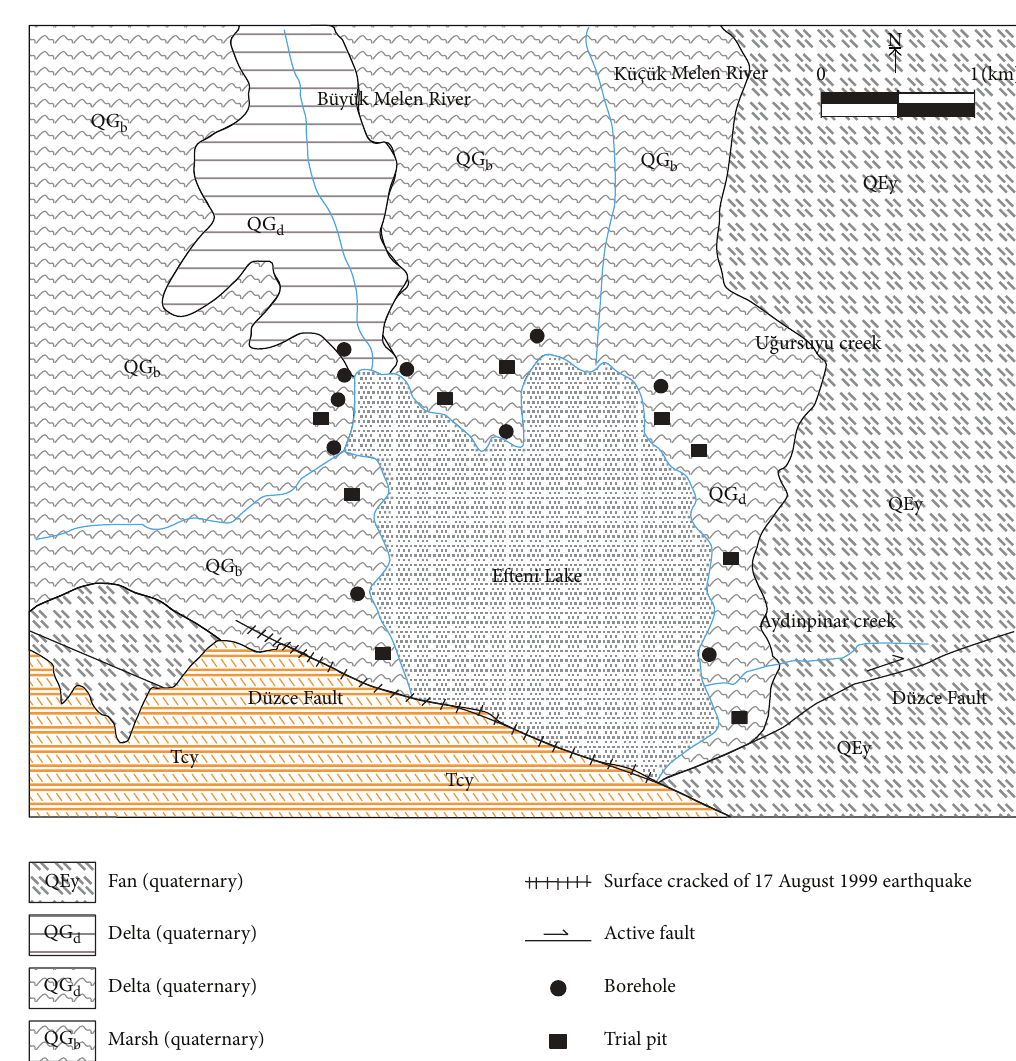
Figure 3: Geological map of the study area and some borehole locations [26].